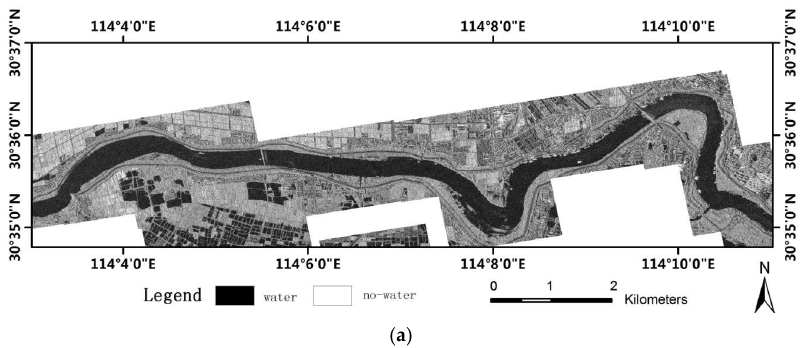
Figure 5. Saliency map comparison (Hanjiang River). ( a ) Original imagery; ( b ) Salience map generated by Itti model; ( c ) Salience map generated by our model.